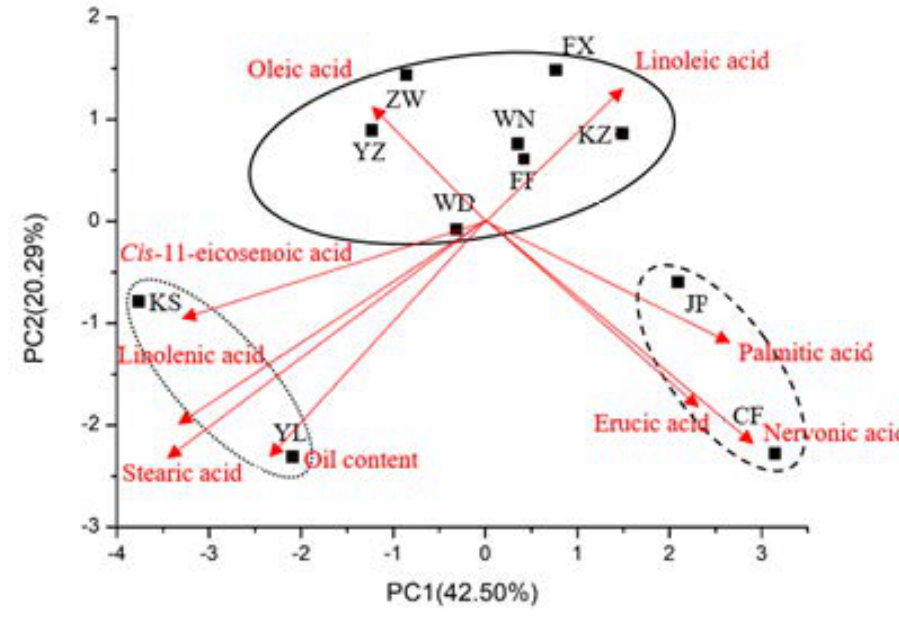
Figure 3. Principal component analysis of seed oil index of A. truncatum from different areas. The natural forest production areas: Horqin Right Wing Middle Banner (YZ), Wudantala Forest Farm (WD), Wengniuteqi Pine mountain Forest Farm (WN) and Chifeng city (CF) of Inner Mongolia, Zhangwu (ZW), Fuxin (FX), Jianping (JP) and Kazuo (KZ) city of Liaoning, Kashi (KS) city of Xinjiang, Fufeng (FF) and Yangling (YL) city of